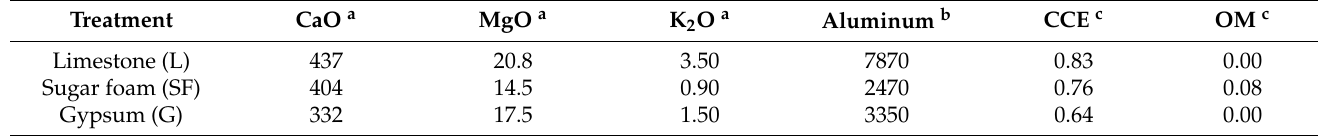
Table 1. Chemical composition of the liming materials expressed as dry matter.